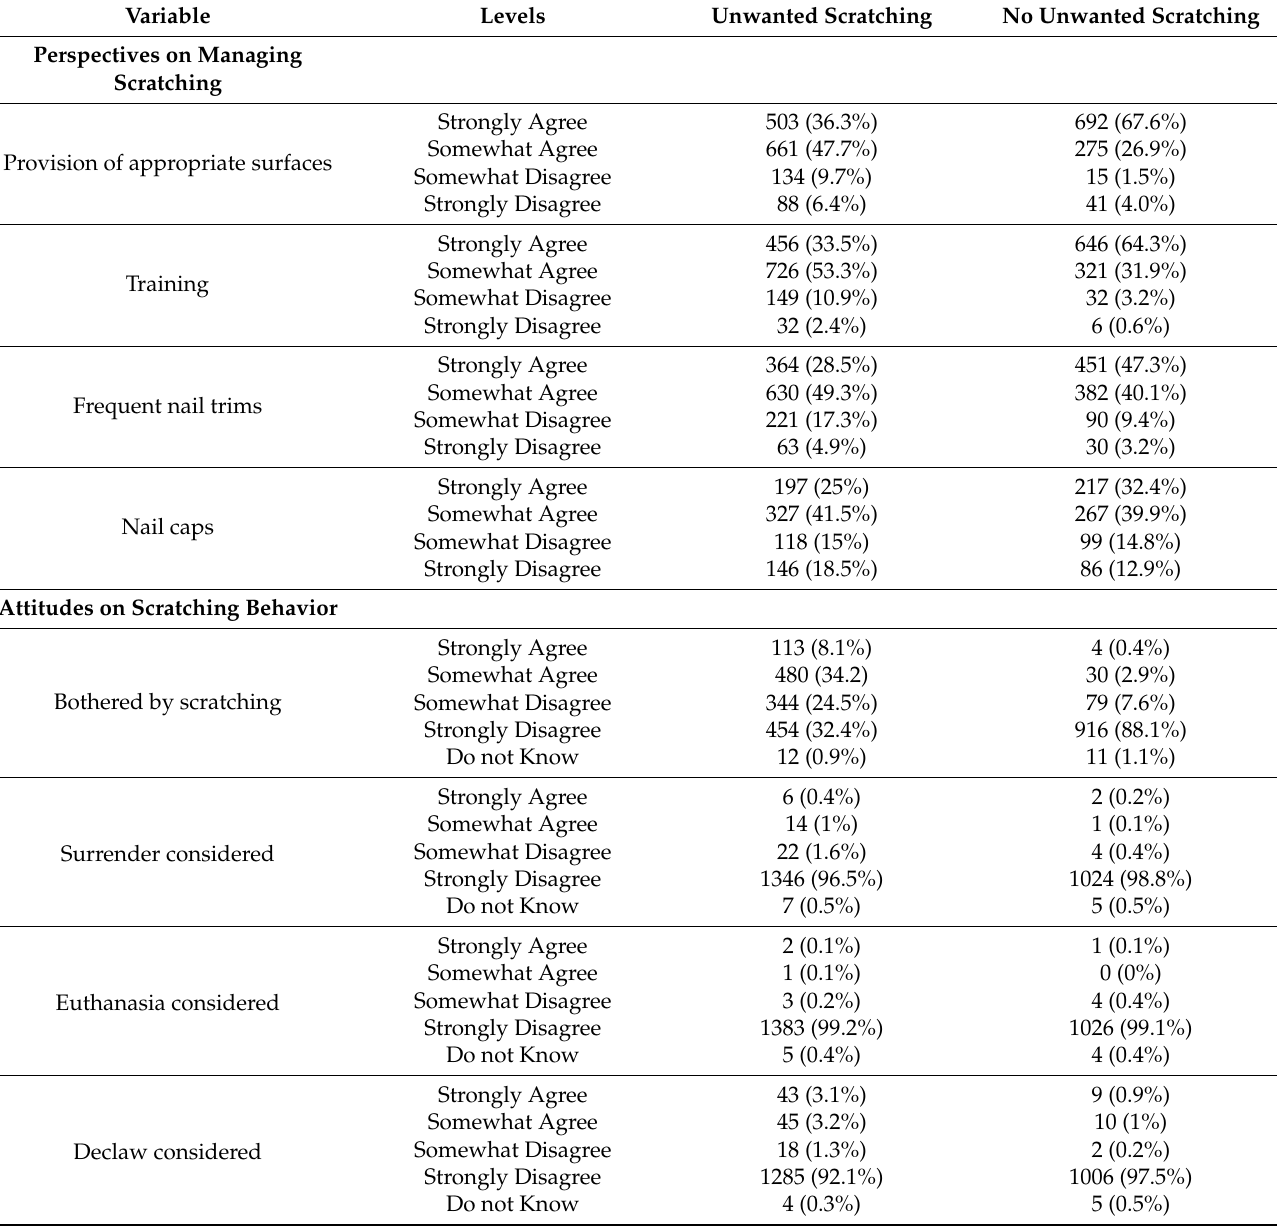
Table 1. Summary statistics comparing perspectives and management strategies for resolving un- wanted scratching for cat owners who reported that their cat performs unwanted scratching ( n = 1406) or no unwanted scratching ( n =